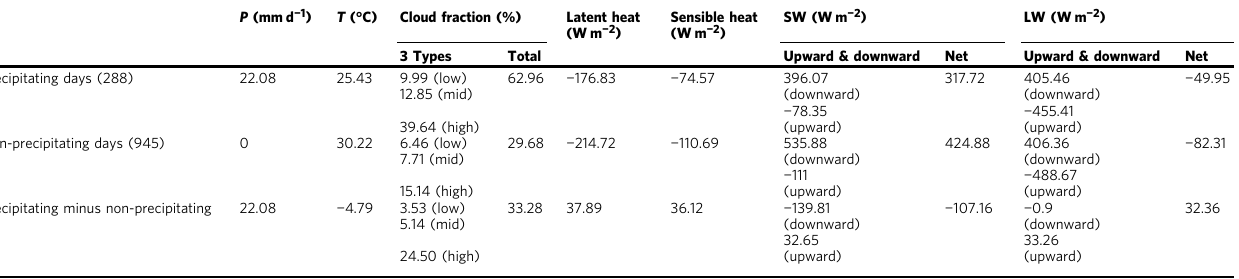
Table 1 Contrast of precipitation, temperature, cloud fraction, sensible heat, latent heat, and radiation terms between precipitating days and non-precipitating